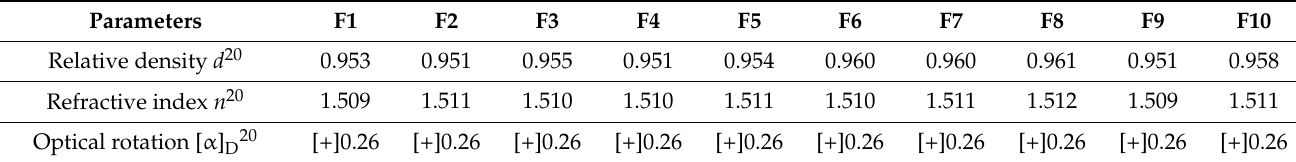
Table 2. Some physical properties of essential oil of O. basilicum cultivated under different light